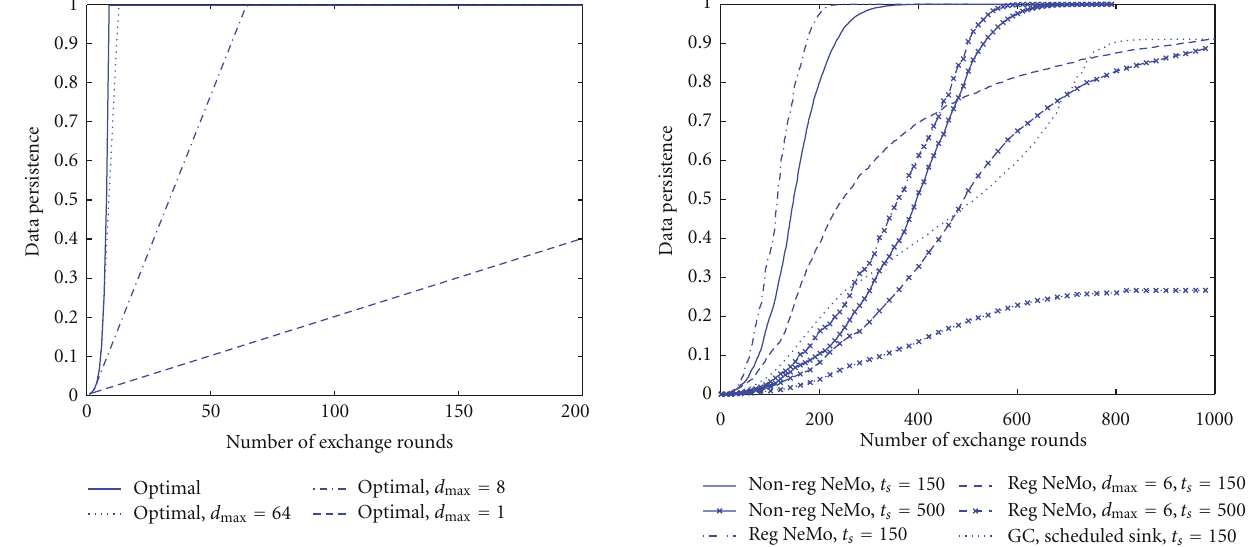
Figure 3: Optimal performance of NeMo with di ff erent d max .